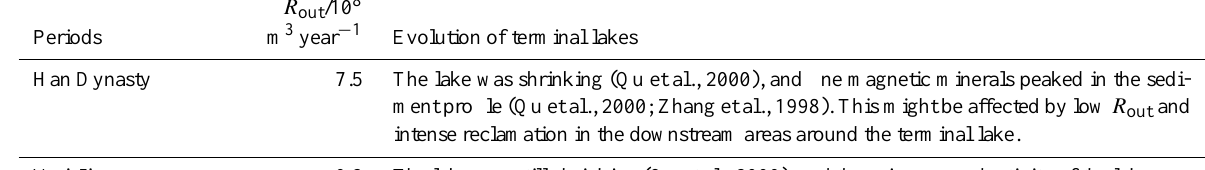
Table 2. The input volumes of water to the terminal lakes ( R out ) and evolution of the terminal lakes in historical periods.